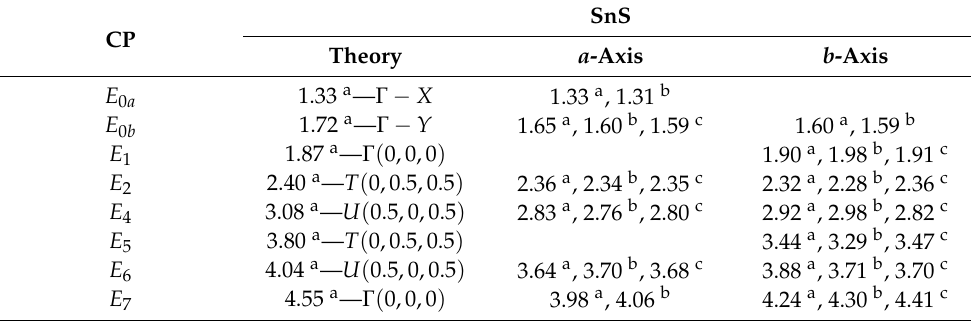
Table 2. As Table 1, for SnS.